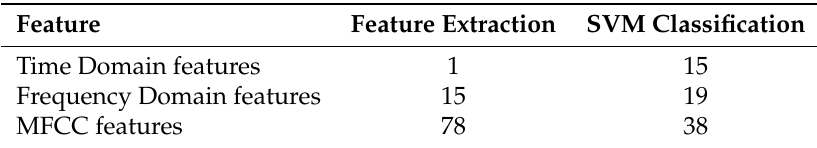
Table 5. Relative execution time of feature extraction vs. SVM